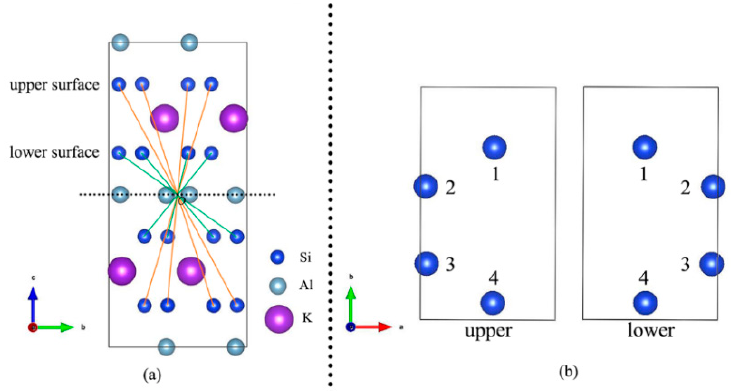
Figure 2. ( a ) The Al IV substitution abided by center-symmetry; ( b ) the label of upper surface and lower surface beside interlayer.